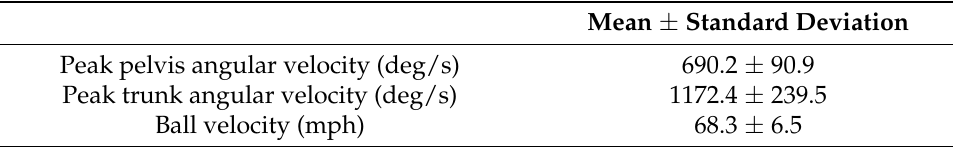
Table 1. Summary of measured ball and peak angular